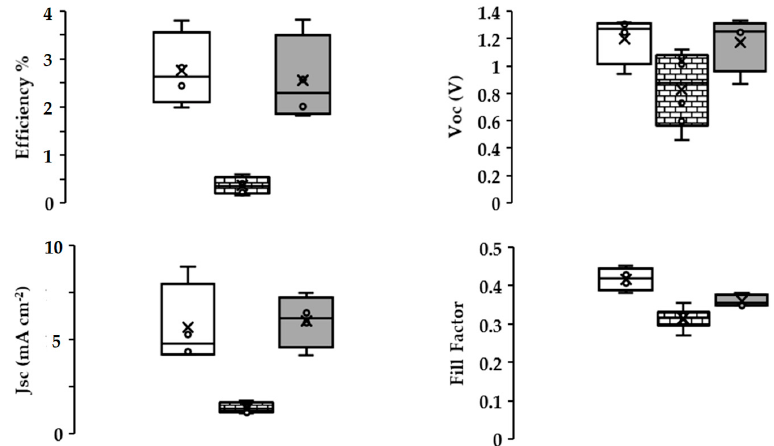
Figure 5. Box plots of (top left) device efficiency, (top right) V oc , (bottom left) normalized J sc and (bottom right) fill factor. TiO 2 , CeO 2 , and MnO 2 scaffold devices are represented by white, brick and grey fill, respectively. The data for each treatment are from 4 devices each with three pixels representing 12 measurements per sample.